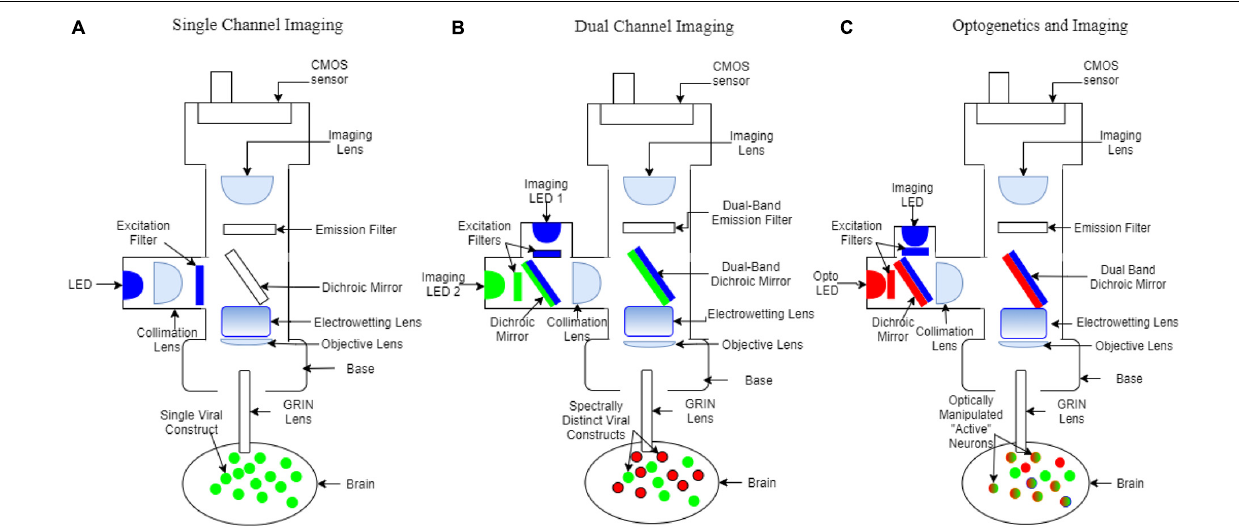
FIGURE 1 | Schematic of miniscope configurations. Colors represent wavelengths (blue: ∼ 480 nm, green: ∼ 520 nm, red: ∼ 560 nm). (A) Single channel fluorescence miniscope and GRIN lens system for imaging virally transduced neurons, or other cells with a single fluorescence activity reporter. (B) Dual-color fluorescence miniscope and GRIN lens system for simultaneous imaging of multiple types or subtypes of neurons. Individual components that differ from the single channel miniscope include an additional excitation filter, dual-band dichroic mirrors and dual-band emission filters, two cell populations virally transduced with activity reporters with non-overlapping fluorescence (red and green), and, in this example, only a single CMOS detector which necessitates interleaving excitation and read-out of images. (C) Optogenetics miniscope used for simultaneous recording and manipulation of neurons within view of the GRIN lens. Differences from the dual-color miniscope include the use of a separate set of filters to allow simultaneous imaging and optogenetic inhibition and a single band emission filter. Strategies include transduction of opsins in connecting brain regions for optogenetic control and with activity reporters in the brain region being imaged. Neurons expressing opsins can be optogenetically stimulated (red) and neurons expressing activity reporters (green) can be imaged within the same